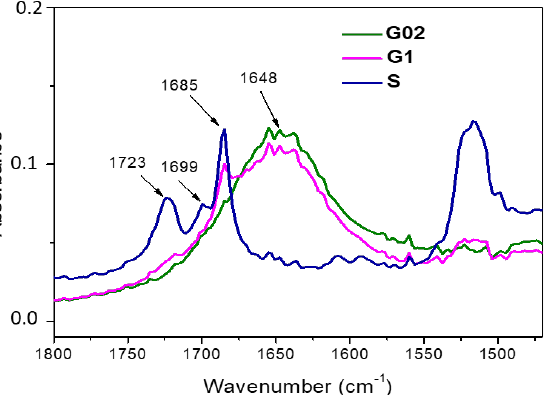
Figure 3. Inset of the FT-IR spectra of the gels G1 and G02 , compared with a solution S of the gelator Boc-L-DOPA(Bn) 2 -OH.